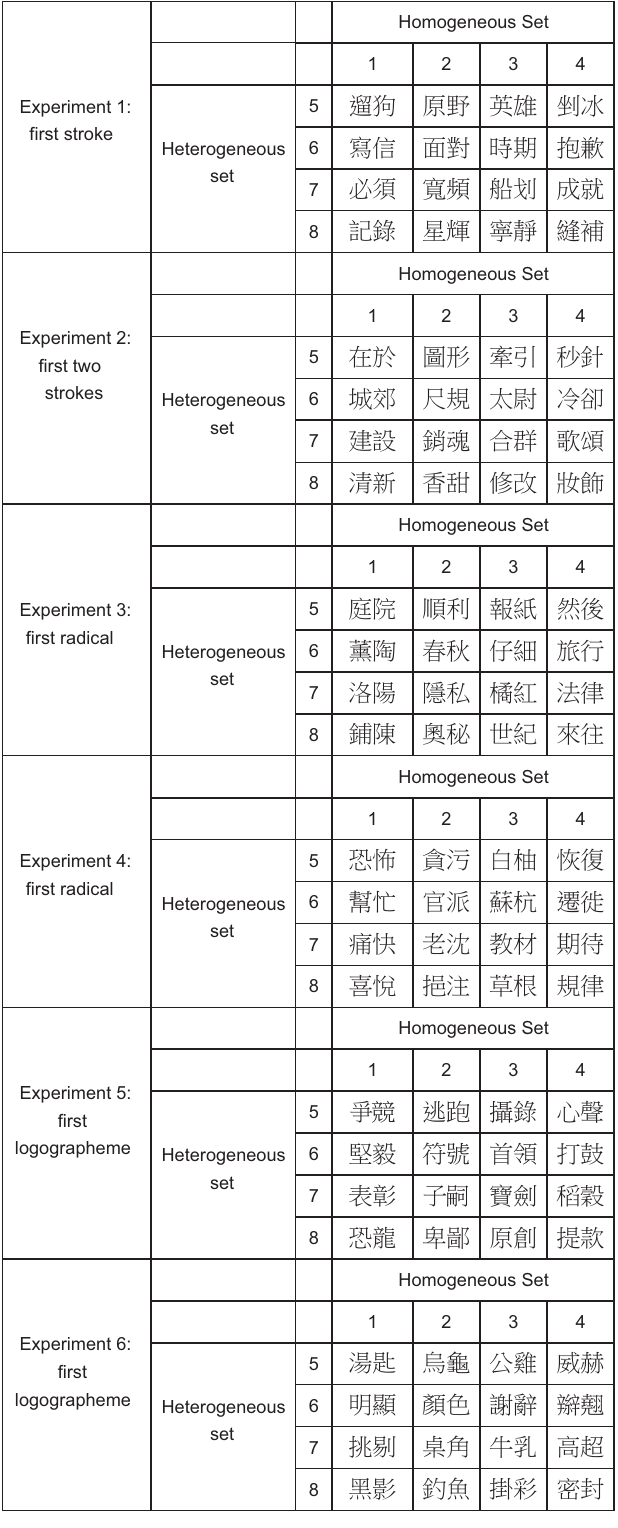
Table 1 | Experimental materials used in each